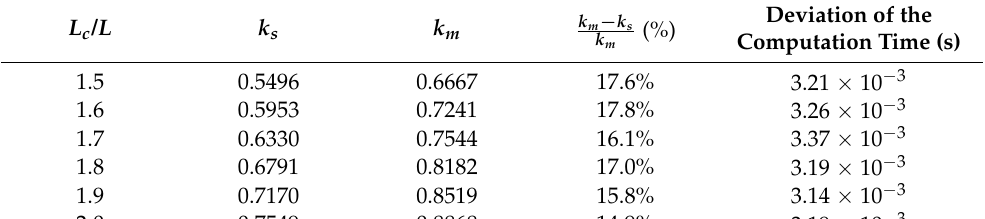
Table 5. The effective thermal conductivity in rectangle pores compared with the EMT method. L c /L